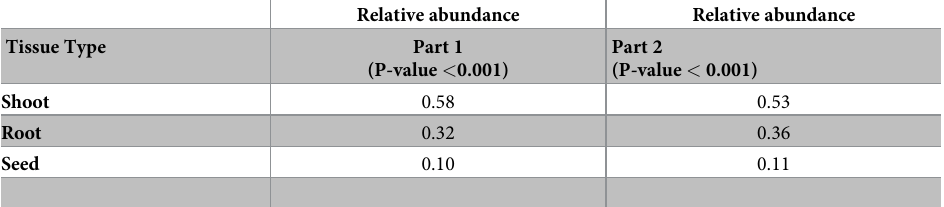
Table 3. Endophytic fungal species abundance among tissues.